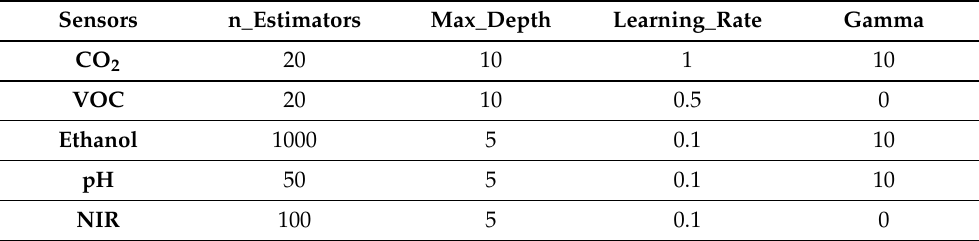
Table 3. Best Model Parameters XGBoost